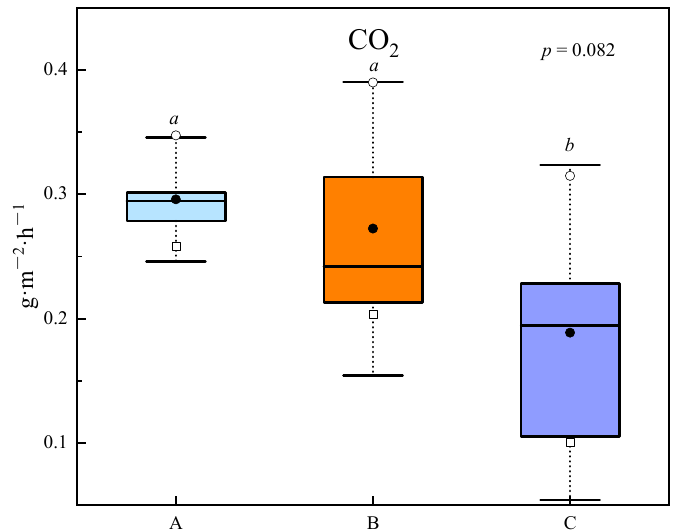
Figure 5. Daytime soil CO 2 effluxes at different sites. (Different letters indicate significant differences among treatments ( p < 0.05).)